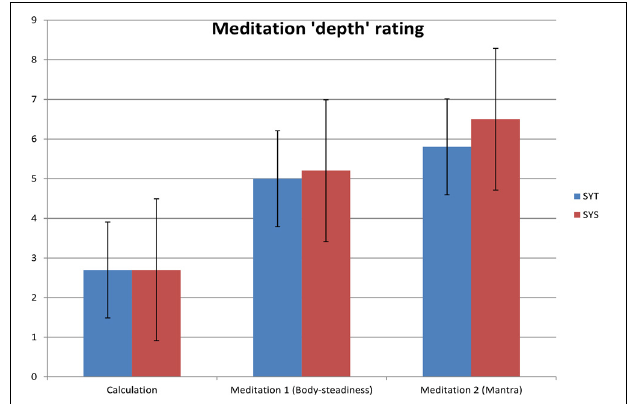
FIGURE 1 | Subjective ratings of meditation